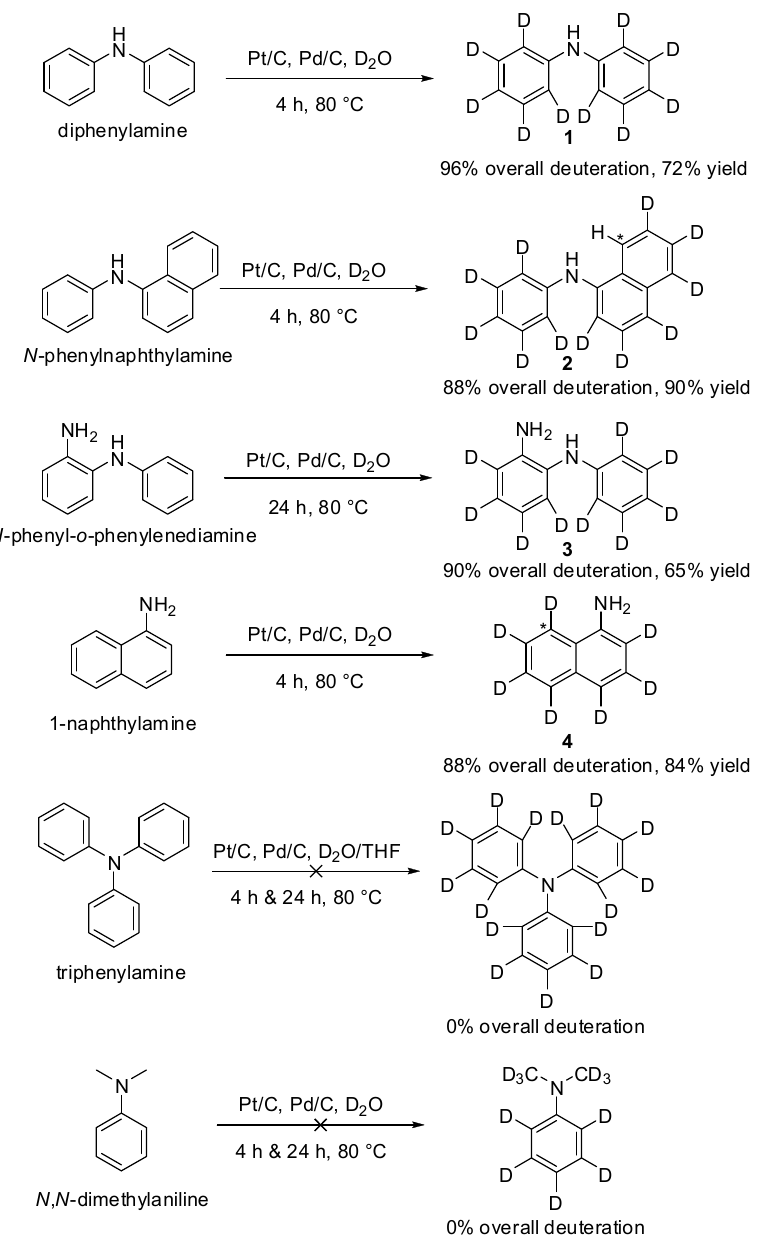
Scheme 2. The synthesis of deuterated arylamines 1 – 4 via H/D exchange in D 2 O, catalyzed by Pt/C and